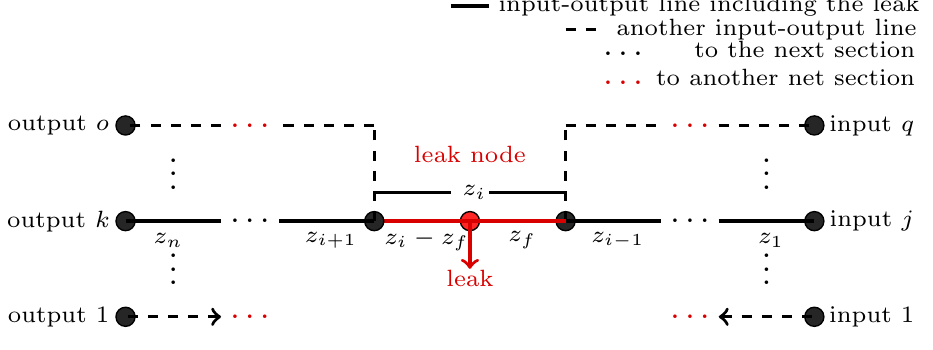
Figure 7. General scheme of a water distribution